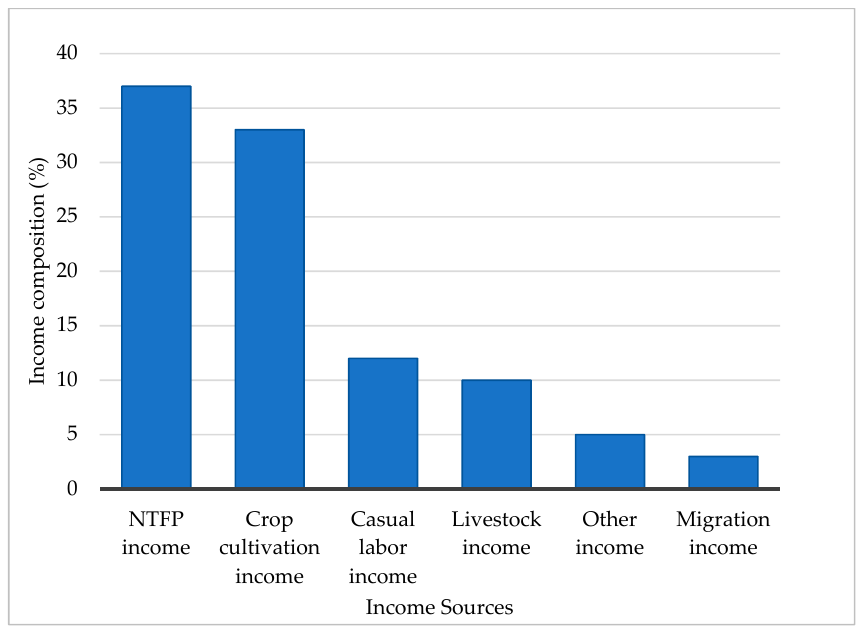
Figure 3. Relative annual household income by income source (n = 330), Taungoo District, 2016 .